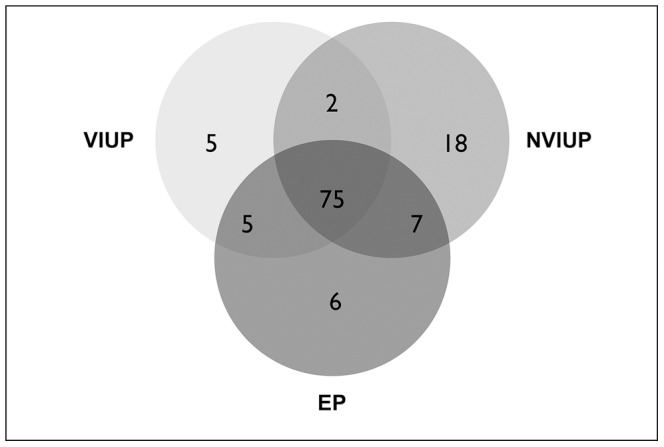
Pooled sera from women undergoing surgical management of EP, surgical management of NVIUP and surgical termination of VIUP were affinity-purified using ProteoMiner™ spin-columns and separated by 1D SDS-PAGE, prior to trypsin digestion and LC-ESI-MS/MS.Interrogation of the SwissProt database produced a total of 118 non-redundant high confidence identities.